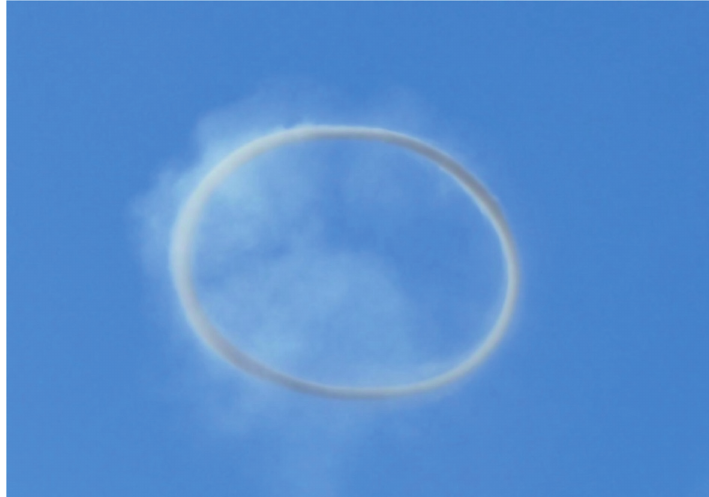
Figure 7. Up in smoke. Computer simulation of a smoke ring from the Amager Bakke Energy Plant© BIG-Bjarke Ingels